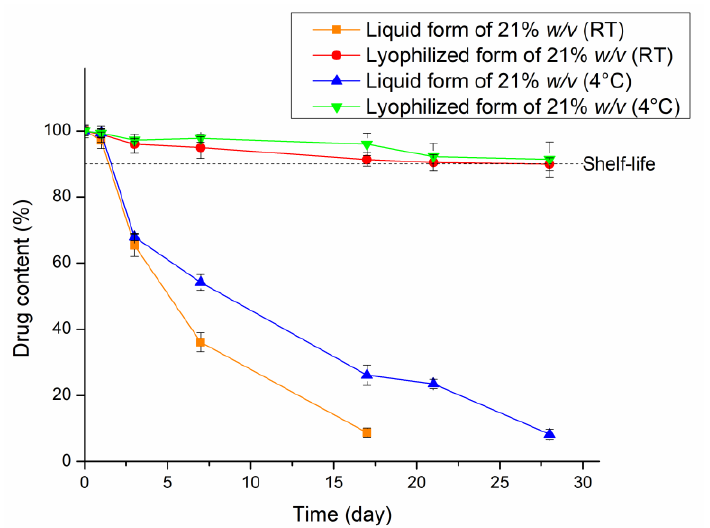
Figure 8. Change of AMT content in the in situ gelling nasal preparation for 4 weeks storage at room temperature (RT) and cold place (4 °C). Data are presented as means ± SD, n = 3.